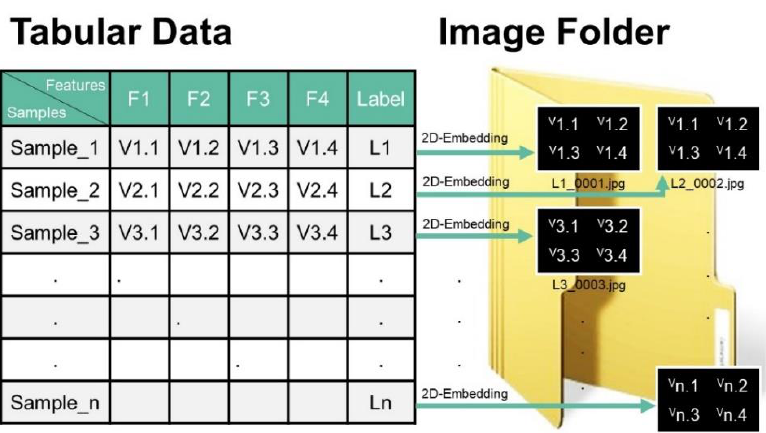
Figure 10. Example of classification of tabular data. Source: Sun et al.